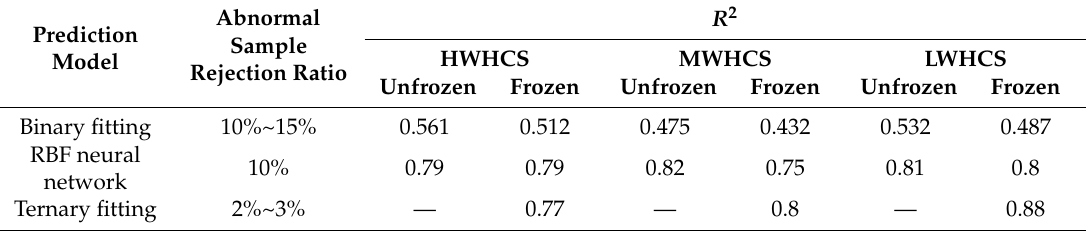
Table 6. R 2 for three prediction models.